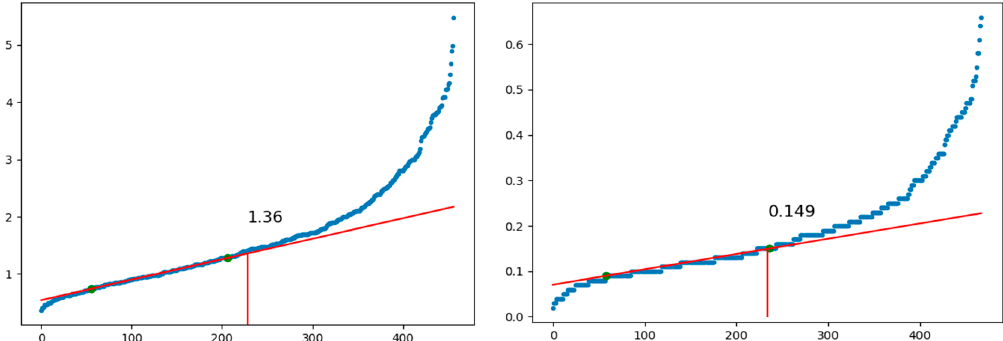
Figure 4. Ranked monthly flow minima according to Kille [44] and mean baseflow value in GER out and FIS out . The green dots are manually selected interpolation points for the fitted red line. Based on daily flow data from the HLNUG [33].